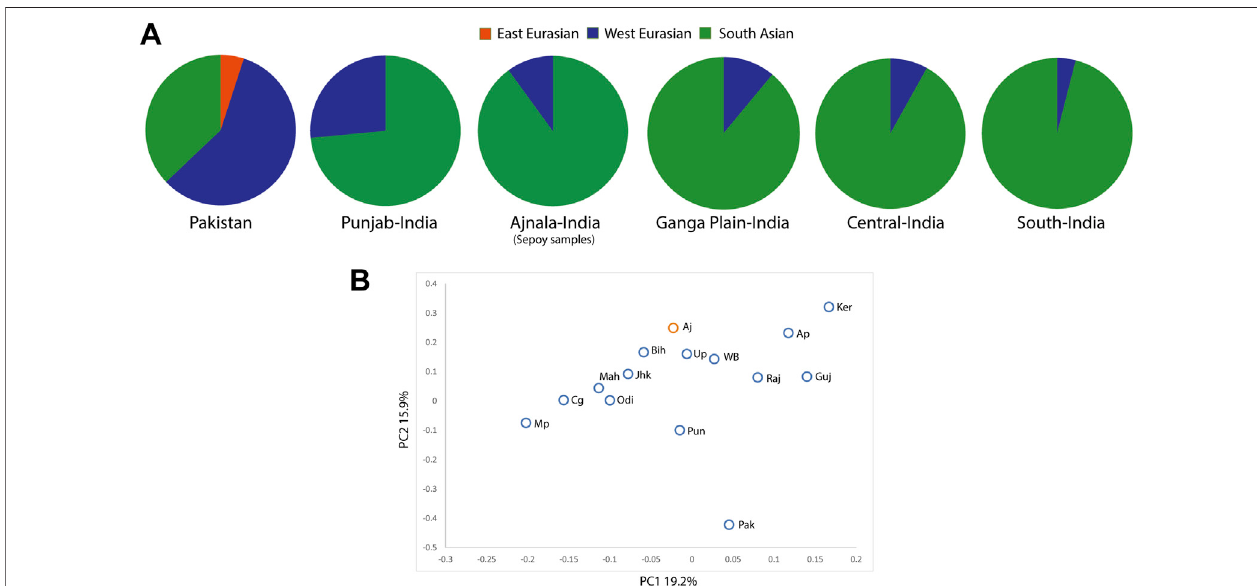
FIGURE 2 |(A) Pie chart showing the proportion of the East Eurasian, West Eurasian, and South Asian genetic ancestries among the studied group (Ajnala, India), with respect to their adjacent geographical regions. South Asian haplogroups: M2-M6, M18, M25, M30-M67, N5, R5-R8, R30-R32, and U2a,b; west Eurasian haplogroups:HV,H,J,K,R0,R1,R2,U1-U5,U7,U8,U9,W,andX;eastEurasianhaplogroups:A-G,M7-M12,R22,andN9. (B) Principalcomponentanalysis(PCA)on maternalhaplogroupsofSouth Asianpopulations, showingtheaf fi nity ofsepoy sampleswithSouth Asianpopulations. Pak, Pakistan;Pun,Punjab India; Aj,Ajnala (sepoy samples); Raj, Rajasthan; Guj, Gujarat; Mah, Maharashtra; Up, Uttar Pradesh; Bih, Bihar; Jhk, Jharkhand; WB, West Bengal; Mp, Madhya Pradesh; Cg, Chhattisgarh; Odi, Odisha; Ap, Andhra Pradesh; Ker,